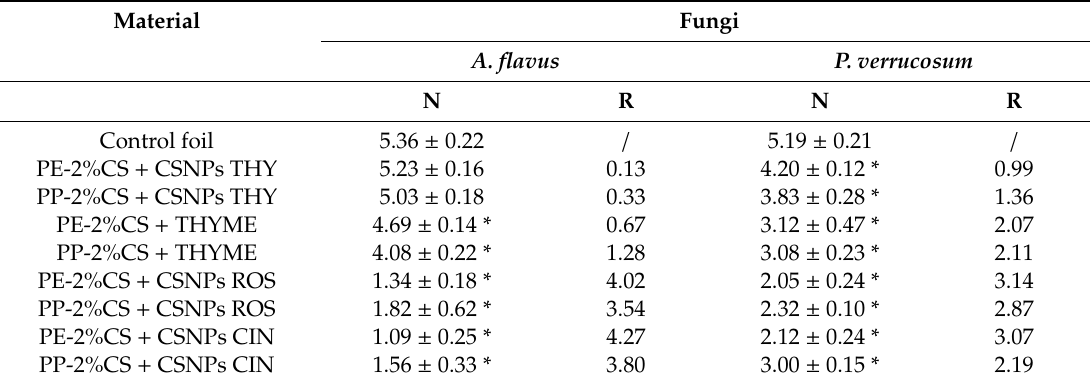
Table 10. Antimicrobial activity against fungi ( Aspergillus flavus , Penicillium verrucosum